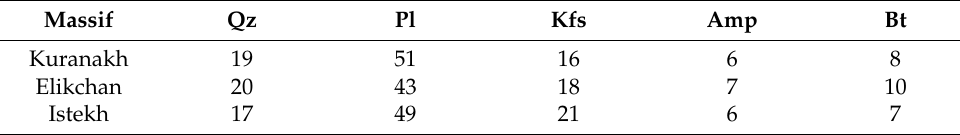
Table 1. Composition of granodiorites (in vol